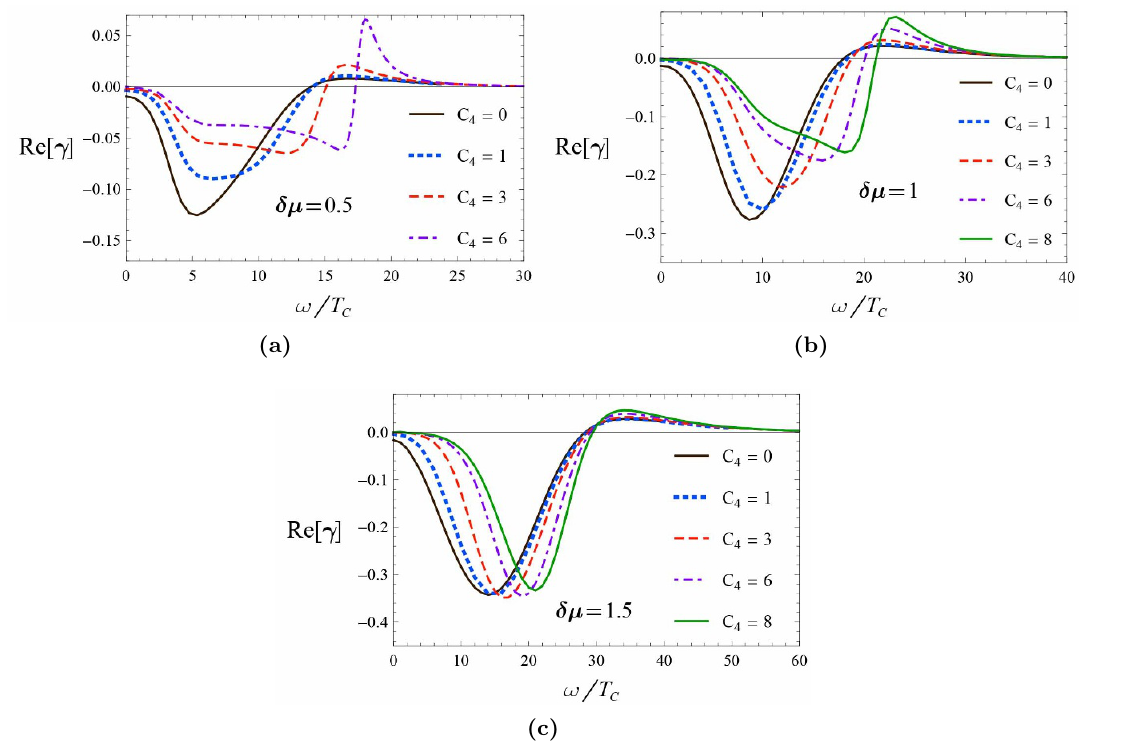
Figure 13. The real part of the mixed conductivity in terms of !=T c for function F ( ) = 2 + C 4 4 with C 4 = 0 ; 1 ; 3 ; 6 ; 8 (solid curve, dotted curve, dashed curve, dot-dashed curve, and pale (green) solid curve) and (cid:14)(cid:22) = 0 : 5 ; 1 ; 1 : 5 ((cid:12)gures (a), (b), and